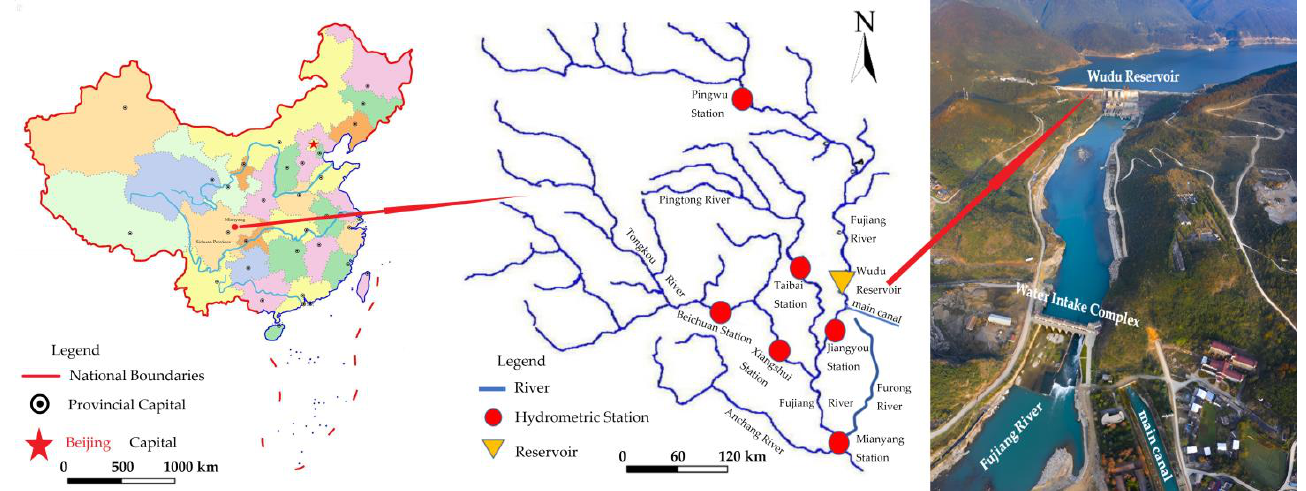
Figure 1. Specific location from Wudu Reservoir to the intake complex in Mianyang City, Sichuan Province, China.